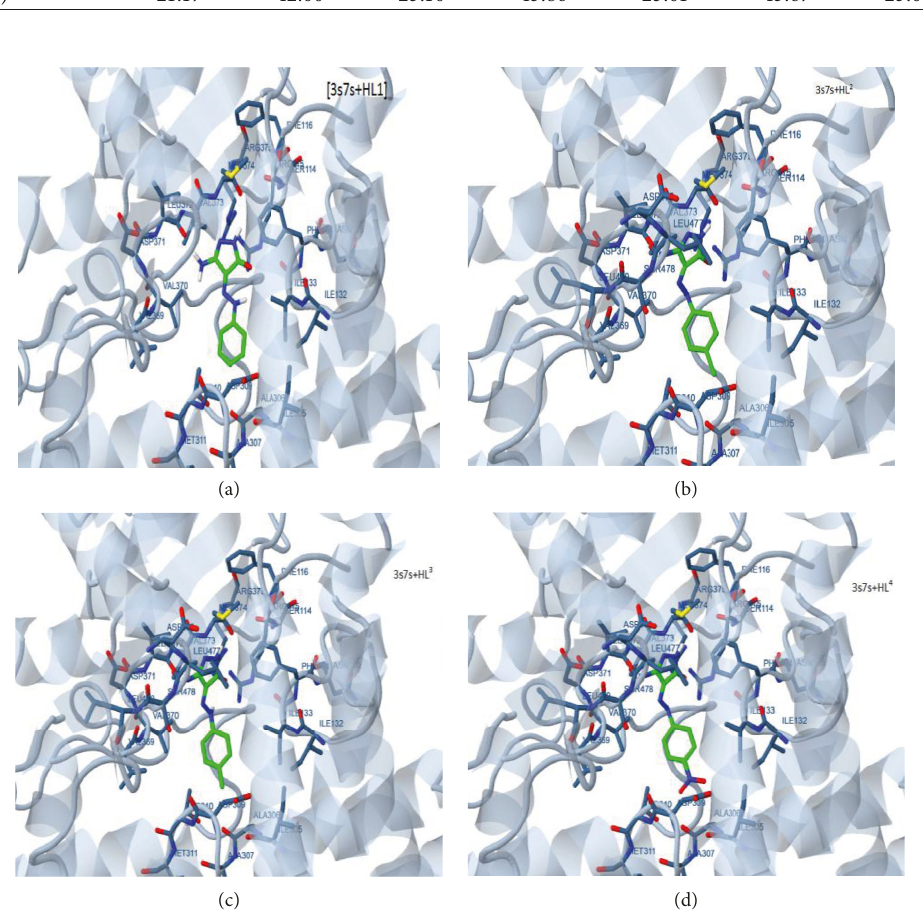
Figure 7: High interacting complexes for 3s7s protein with HL 1–4